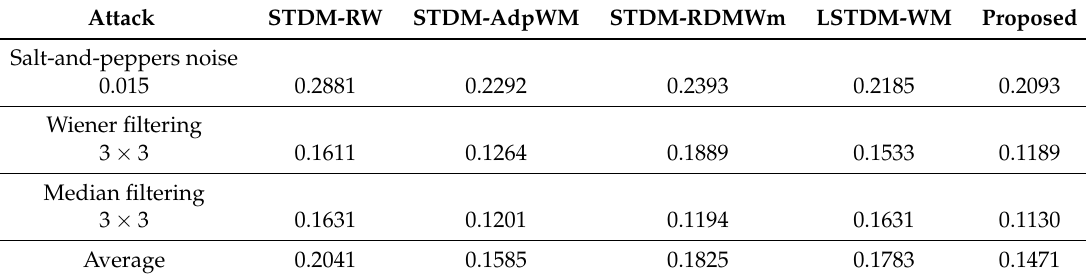
Figure 5. BER versus volumetric scaling factor for different watermarking algorithms with SSIM = 0.982. Table 1. The BER comparisons for some common attacks with SSIM =